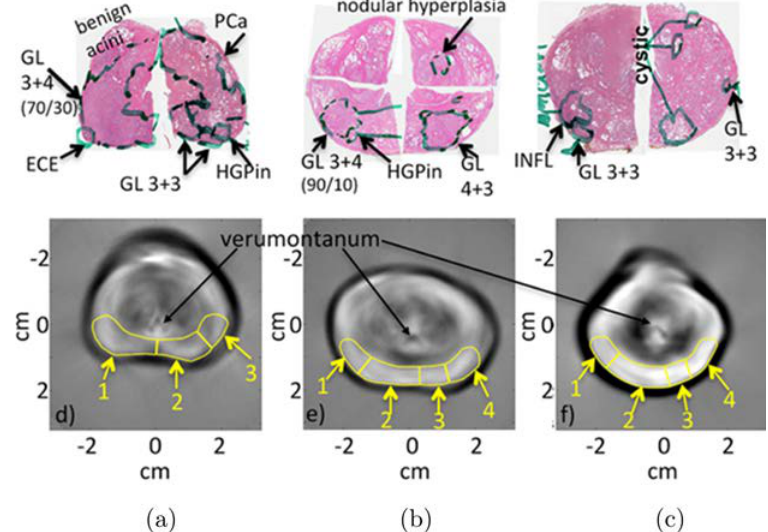
Fig. 15. (a – c) Three pathological sections of verumontanum. (d – f) The corresponding TAI reconstructions.